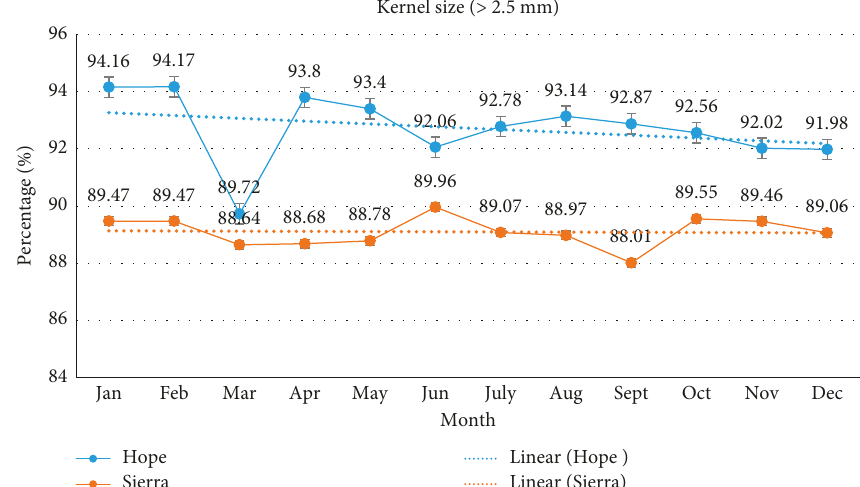
Figure 8: Comparison of > 2.5mm kernel size for Hope and Sierra malting barley varieties over the 12-month storage period.